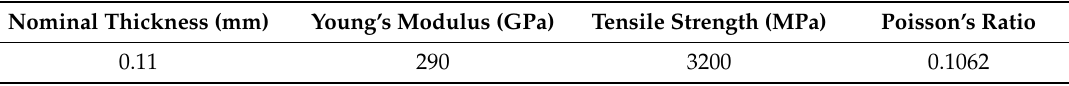
Table 2. Fiber-reinforced polymer (FRP) cloth material mechanical properties.